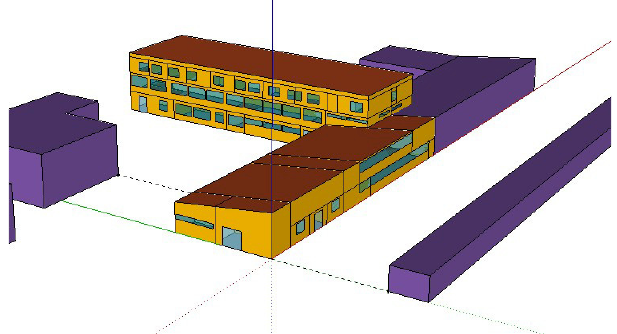
Fig. 1. 3D representation of the monitored